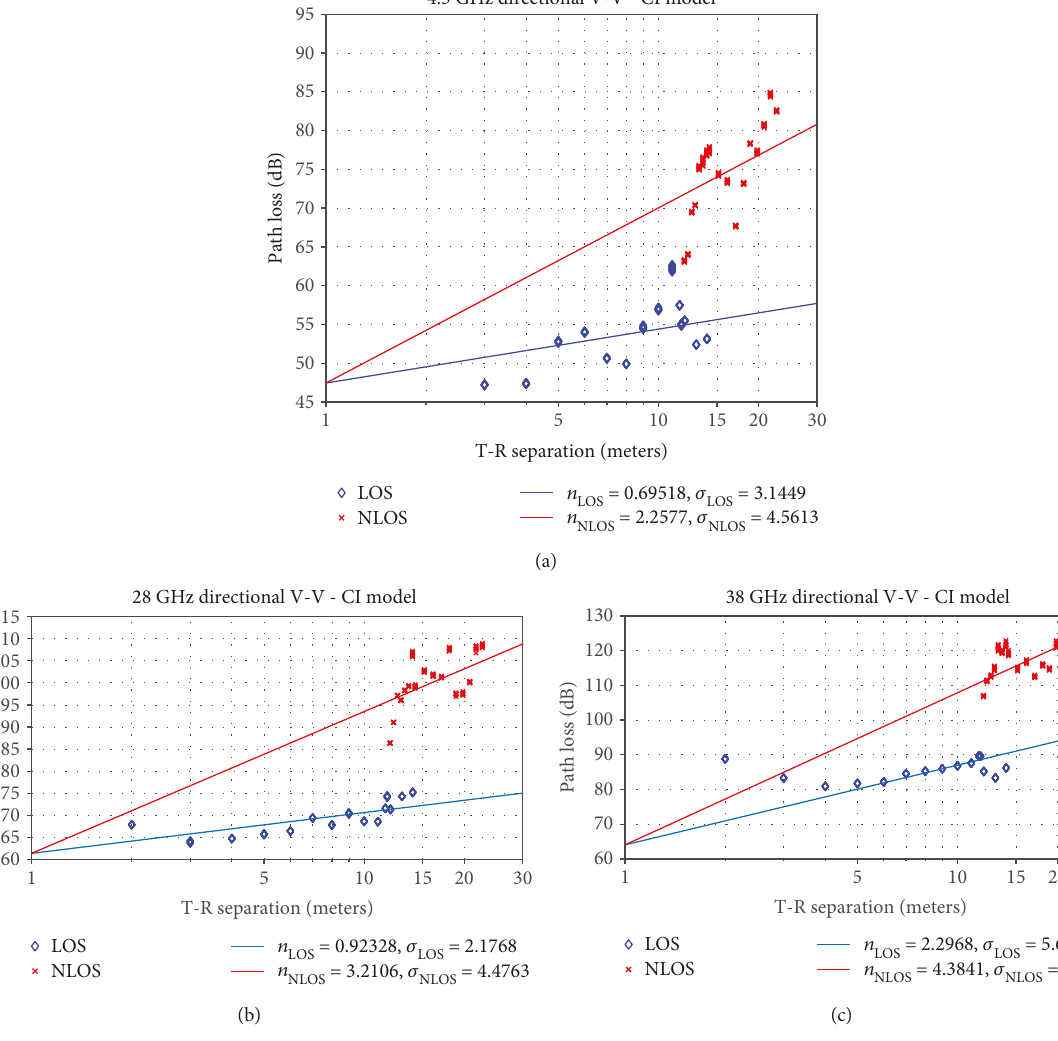
Figure 2: Directional V-V CI path loss model for LOS and NLOS (a) 4.5GHz, (b) 28GHz, and (c)